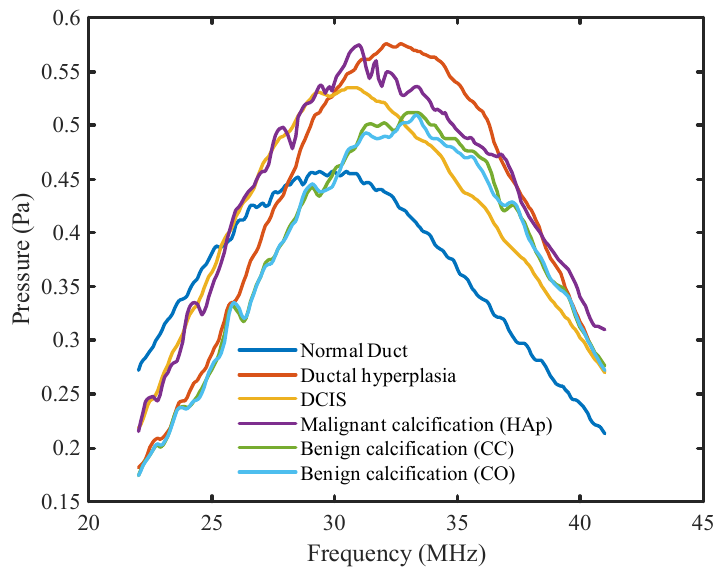
Figure 6. Frequency spectrums for all DOS models for the pitch-catch mode.